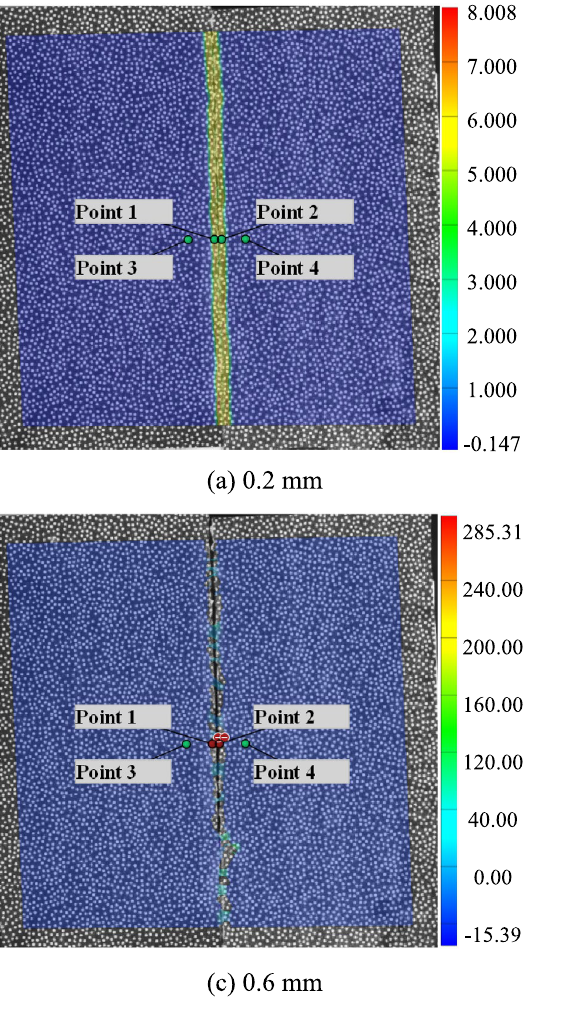
Figure 7. DIC strain nephogram and measuring point layout.